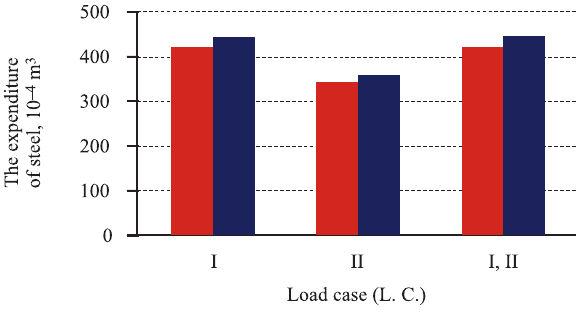
Fig. 7. The expenditure of steel, when h = 2.0